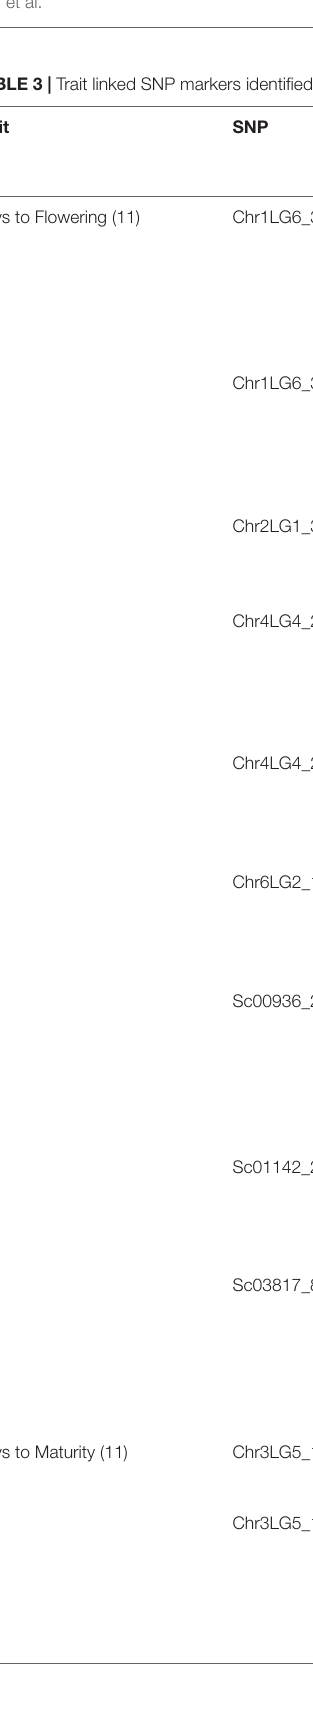
TABLe 3 | Trait linked SNP markers identified by association analysis of various pea phenotypes using the mixed linear model (MLM). Trait SnP Year/Station P value r-square of Days to Flowering